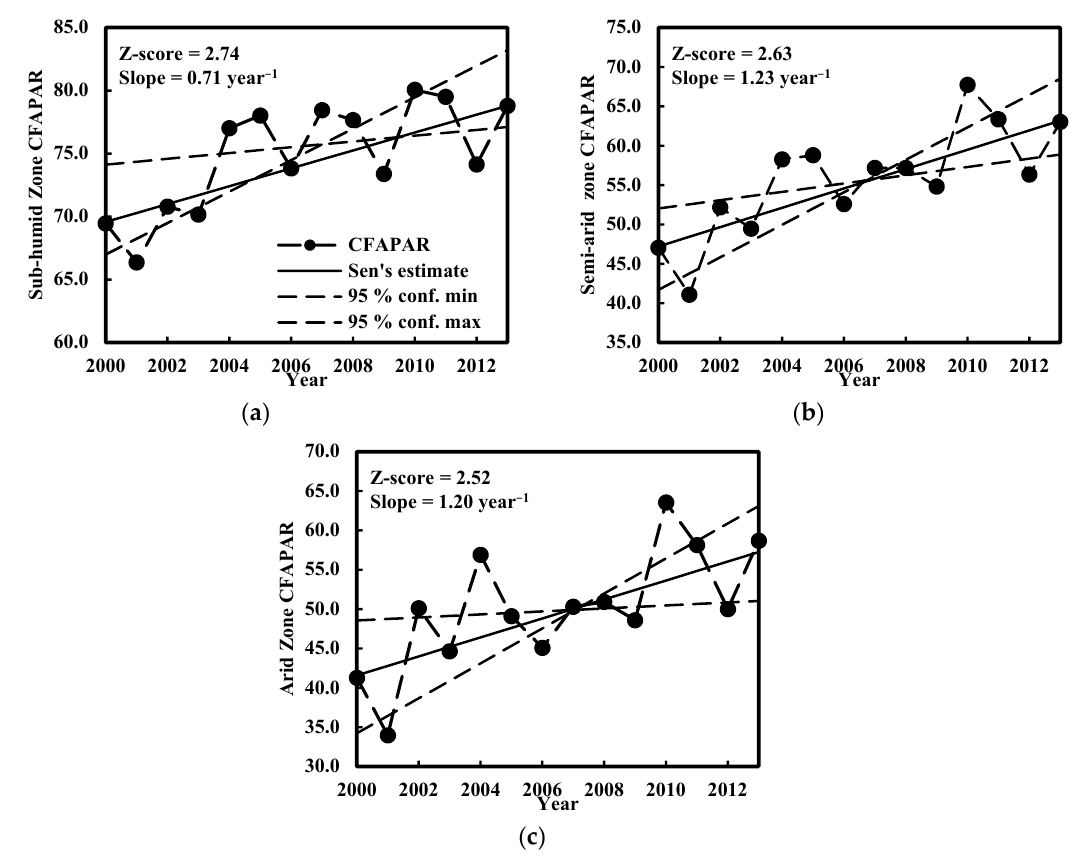
Figure 8. Temporal trends of annual CFPAR in three agro-climatic zones in the Canadian Prairies, sub-humid zone ( a ); semi-arid zone ( b ); and arid zone ( c ); respectively.